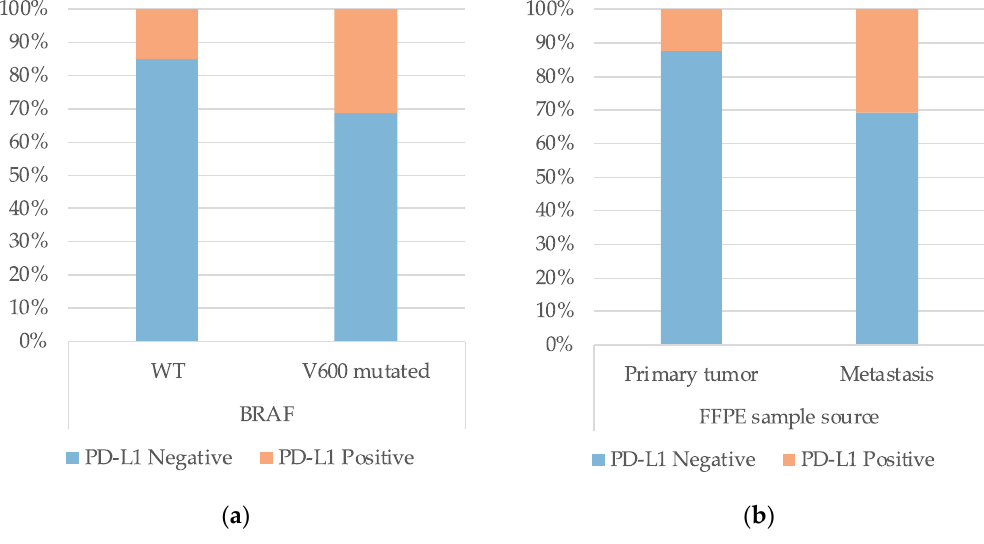
Figure 4. Association of ( a ) BRAF V600 mutation status and ( b ) source of FFPE tumor samples with PD ‐ L1 expression profile. PD-L1 expression